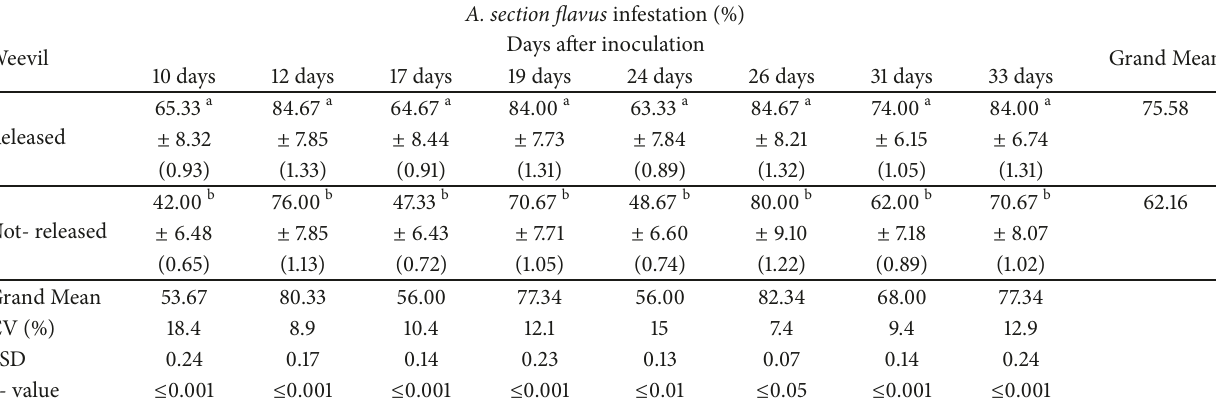
Table 2: Effect of weevil on spread of Aspergillus section flavi . on maize seeds from August to September, 2016.